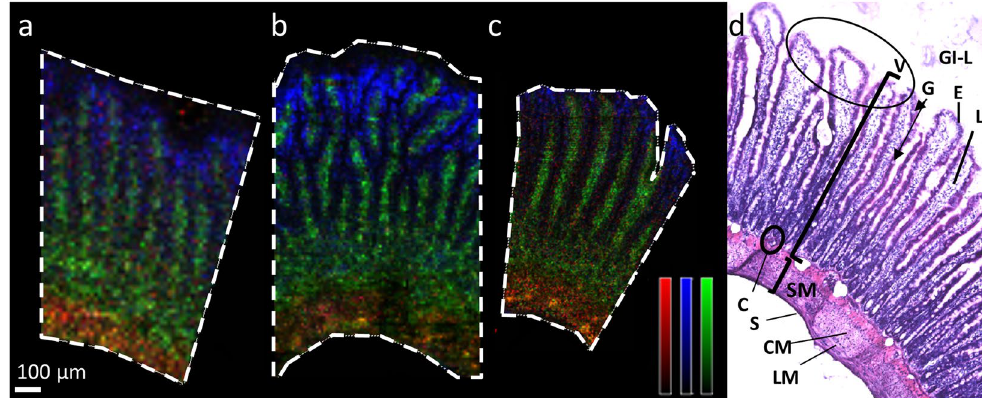
Figure 1. Ion distribution images of three different endogenous compounds. ( a–c ) MALDI MSI ion distribution images of three different endogenous compounds (m/z 772 (green), m/z 769 (red) m/z 804 (blue)) representing different anatomical structures of the intestine lamina propria, submucosa, and epithelial cell layer, respectively. Data was acquired at three different spatial resolutions on three different tissue sections from intestine ( a ) 15 µ m, ( b ) 10 µ m, and ( c ) 5 µ m. The ion intensities are displayed on monochrome colour scales where red is scaled to 50% of max intensity, blue is scaled to 25% of max intensity, and green is scaled to 60% of max intensity. Scale bar 100 µ m. ( d ) H&E stained image of fresh frozen rat intestine processed in same way as sections for MSI analysis with annotated regions of the intestine. GI-L = gastrointestinal lumen; V = villi, oval circle villus tips; SM = submucosa; E = epithelial enterocytes (dark eosinophilic stain); G = goblet cell (arrow tip, not stained in H&E); LP = lamina propria; C = crypt base; S = serosa; LM = longitudinal muscle; CM = circular